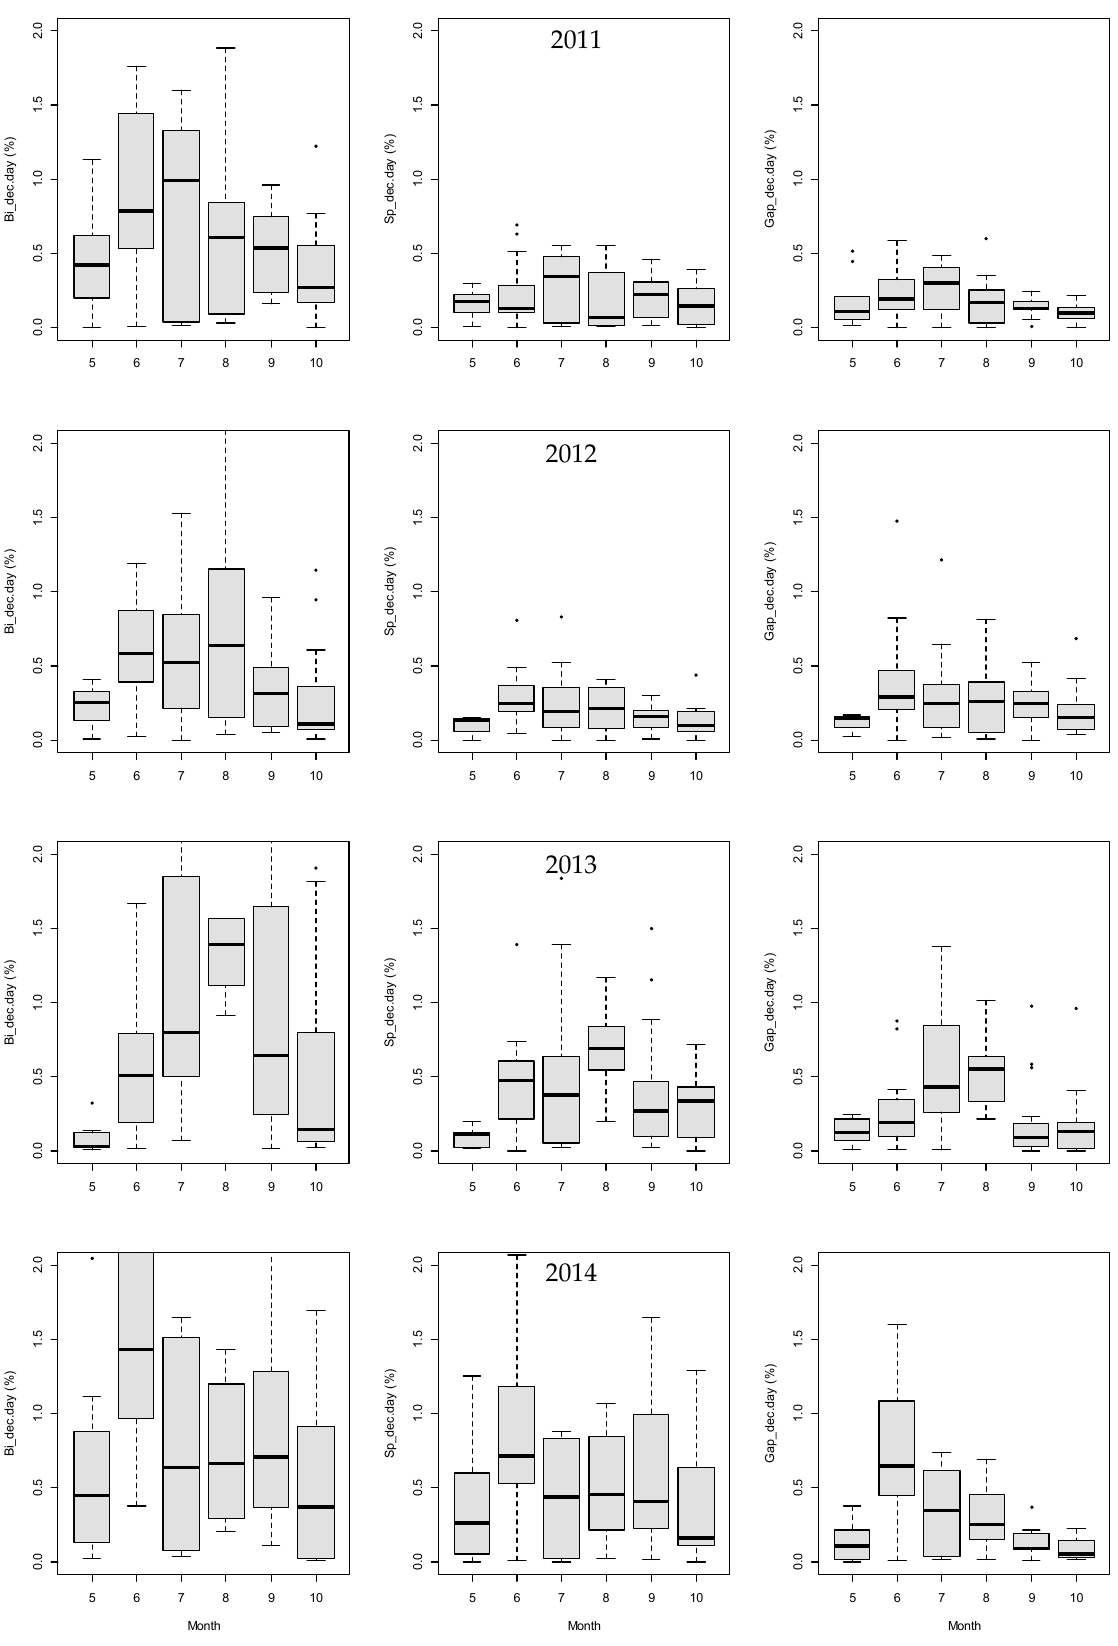
Figure 8. Boxplots of the average daily volumetric topsoil moisture decreases (%) between precipitation events by month during the 2011-14 growing seasons.